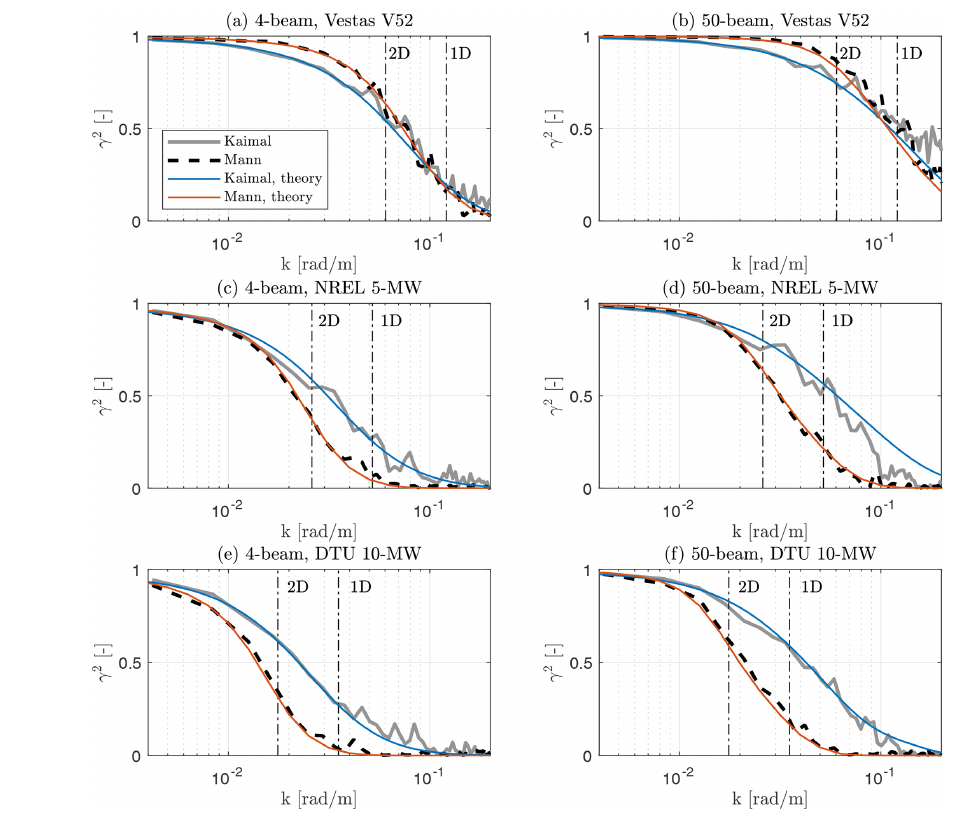
Figure 3. Magnitude-squared coherence γ 2 between lidar measurements and the REWS. Results (a, c, e) for the 4-beam scan pattern and (b, d, f) the 50-beam circular scan pattern. From top to bottom, the plots show results for the Vestas V52 turbine, NREL 5MW turbine and DTU 10MW turbine. The dash–dot lines labeled 1 and 2 D represent the wavenumbers k = 2 π “theory” denotes the theoretical